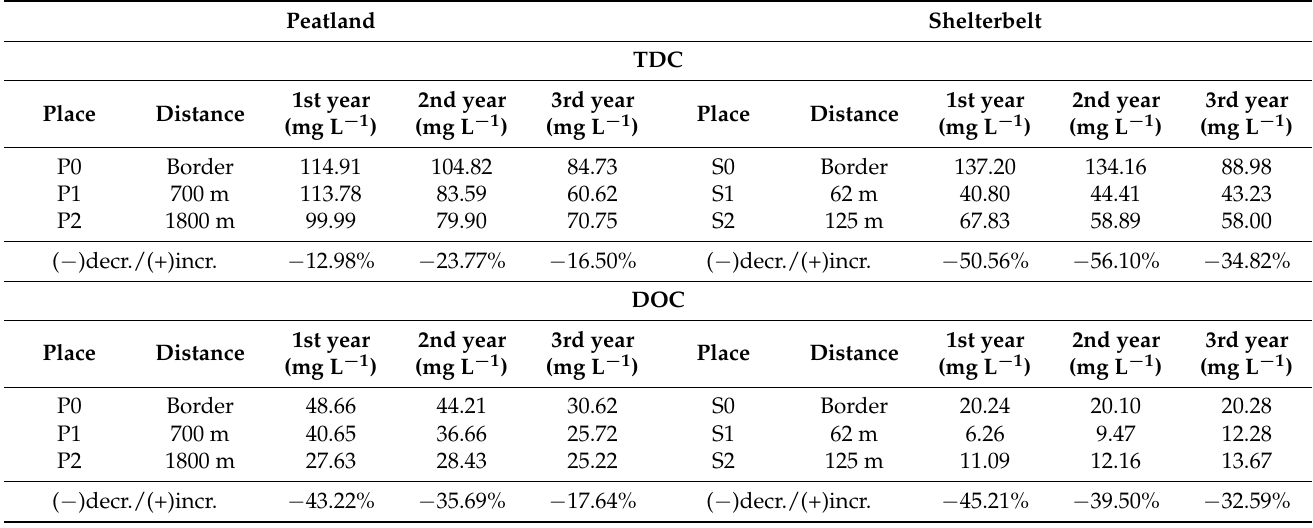
Table 4. Mean concentrations of TDC and DOC in groundwater under peatland and shelterbelt soils.